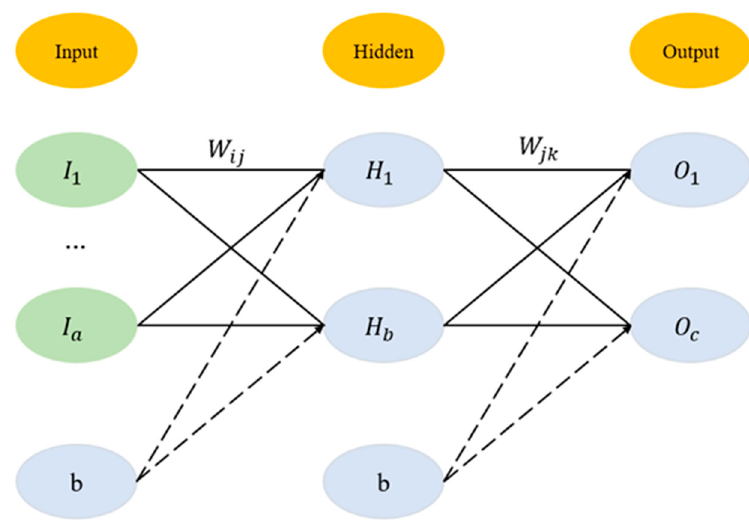
Figure 3. Schematic diagram of neural network algorithm.